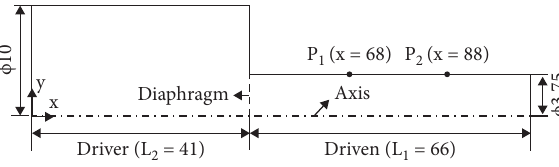
Figure 3: Computational domain for numerical